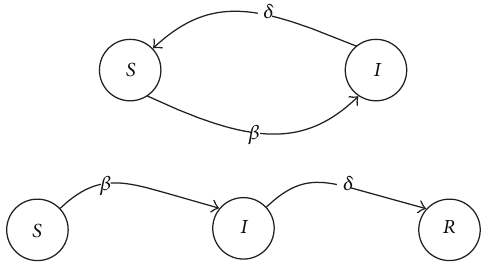
Figure 1: Epidemic processes with 𝑆 susceptible, 𝐼 infected, and 𝑅 removed (or recovered) states and 𝛽 infection and 𝛿 recovery rates based on SIS and SIR